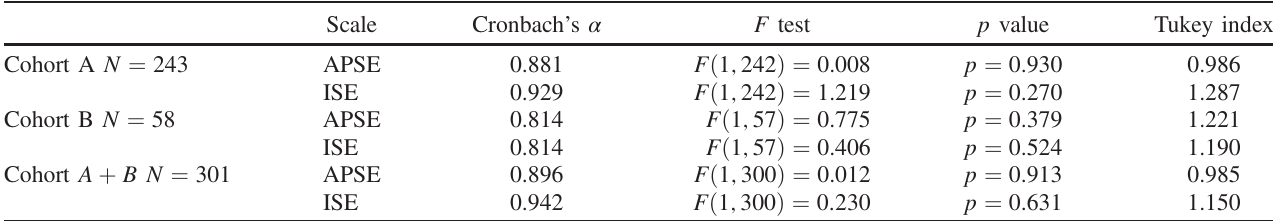
TABLE IV. Reliability statistics for the individual and combined